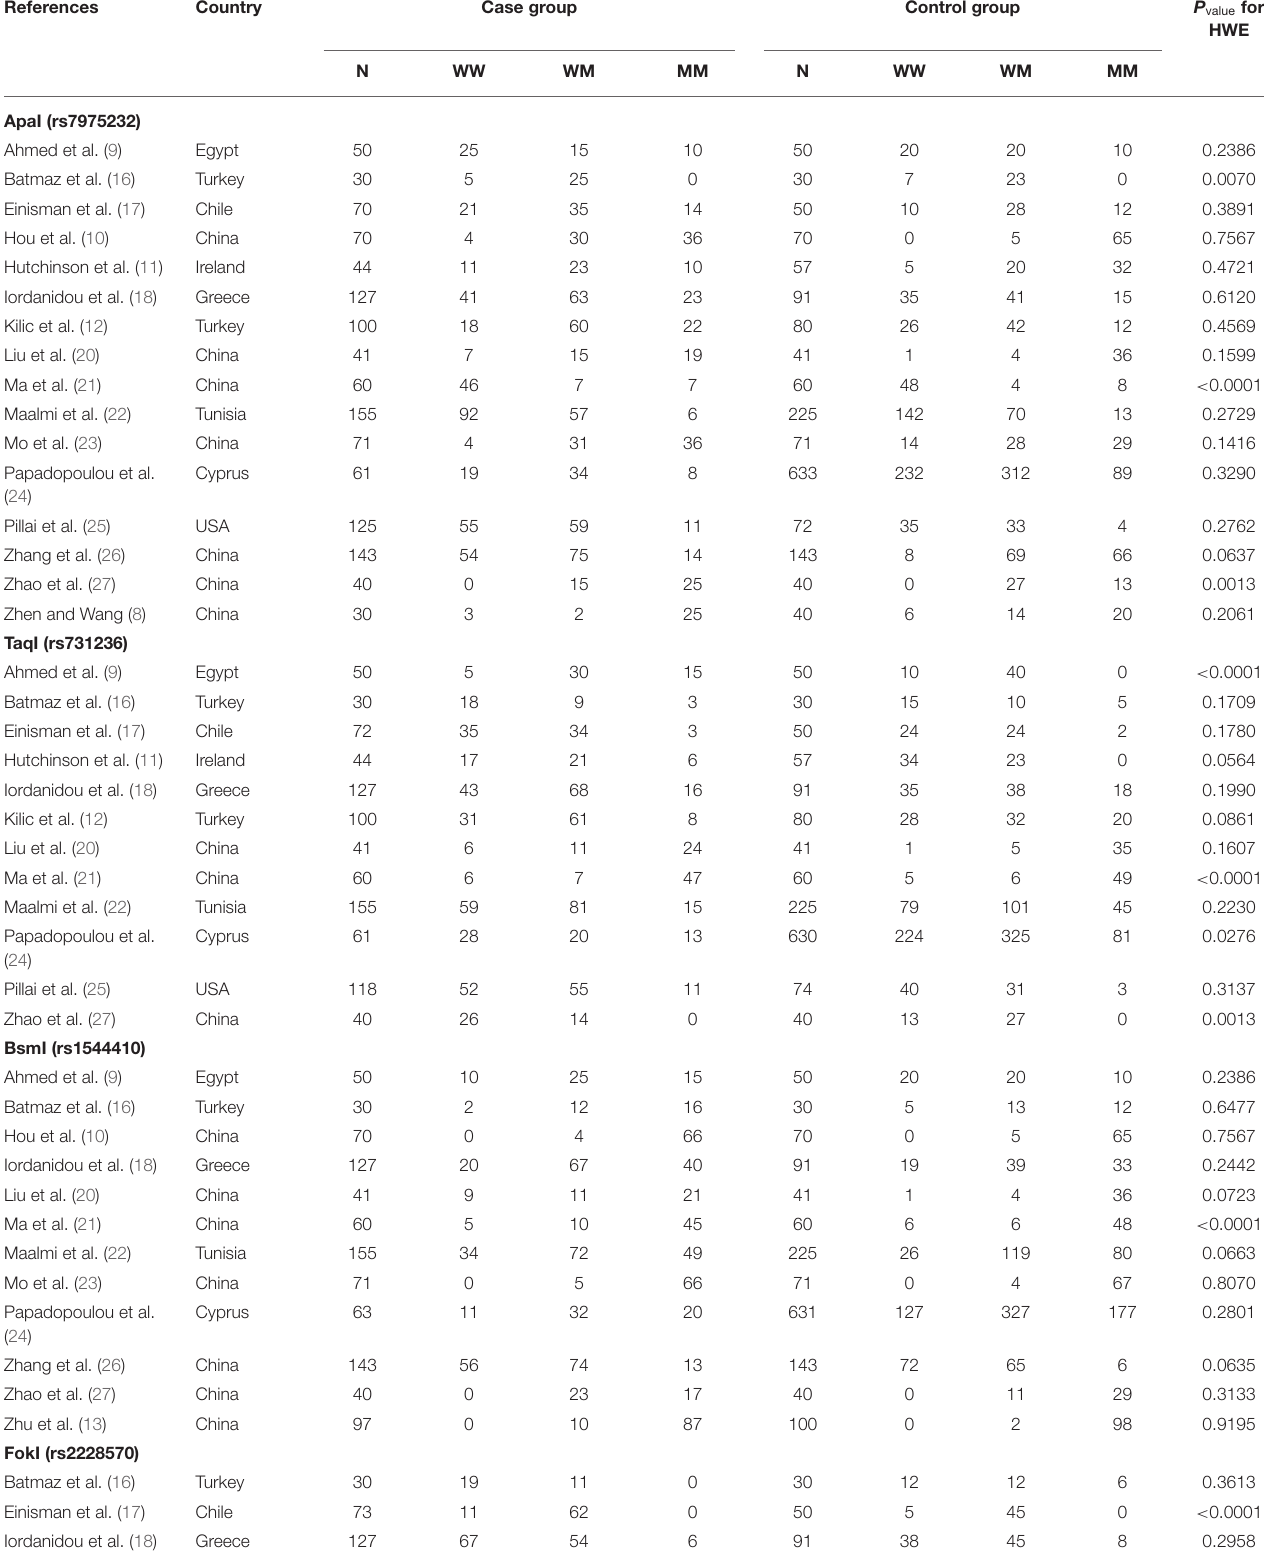
TABLE 2 | Frequency distribution of gene polymorphisms in the experimental group and the control